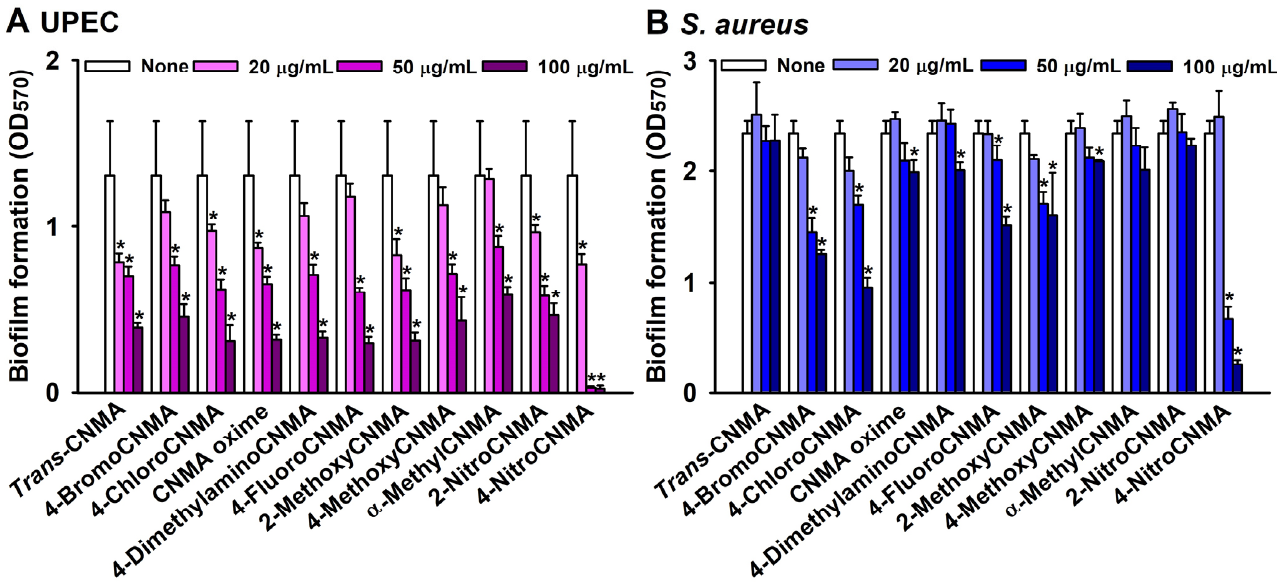
Figure 1. Antibiofilm activities of trans -cinnamaldehyde ( trans -CNMA) and its derivatives. Antibiofilm screening against UPEC ( A ) and S. aureus ( B ). Error bars indicate standard deviations. * p < 0.05 vs. nontreated controls (None).